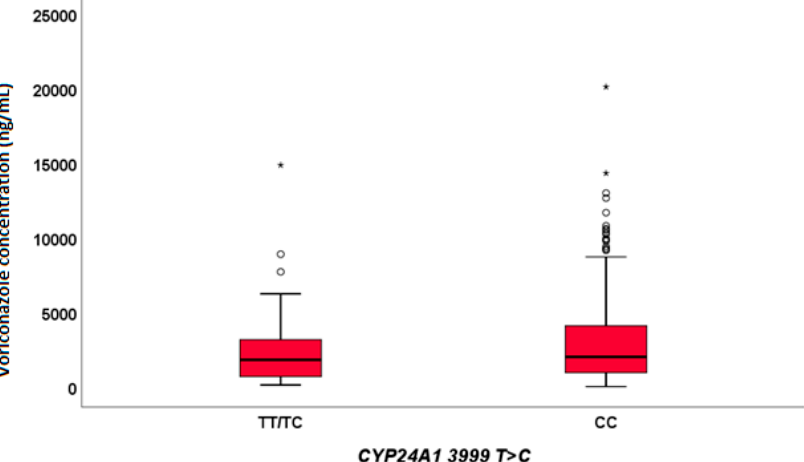
Figure 1. Influence of CYP24A1 3999 T > C SNP on voriconazole exposure ( p = 0.007). Outliers are represented by little circles, and extreme outliers are represented by little stars. Finally, logistic regression analyses evaluating predictors of concentration higher than the efficacy cut-off value of 1000 ng/mL and the toxicity limit of 5000 ng/mL were performed; concerning the first target (Table 2), Caucasian ethnicity, CYP24A1 3999 CC, and CYP27B1 + 2838 TT genotypes were predictive parameters, whereas Caucasian, female sex, e.v. administration and GC 1296 AC/CC genotype patients were for the second aim (Table